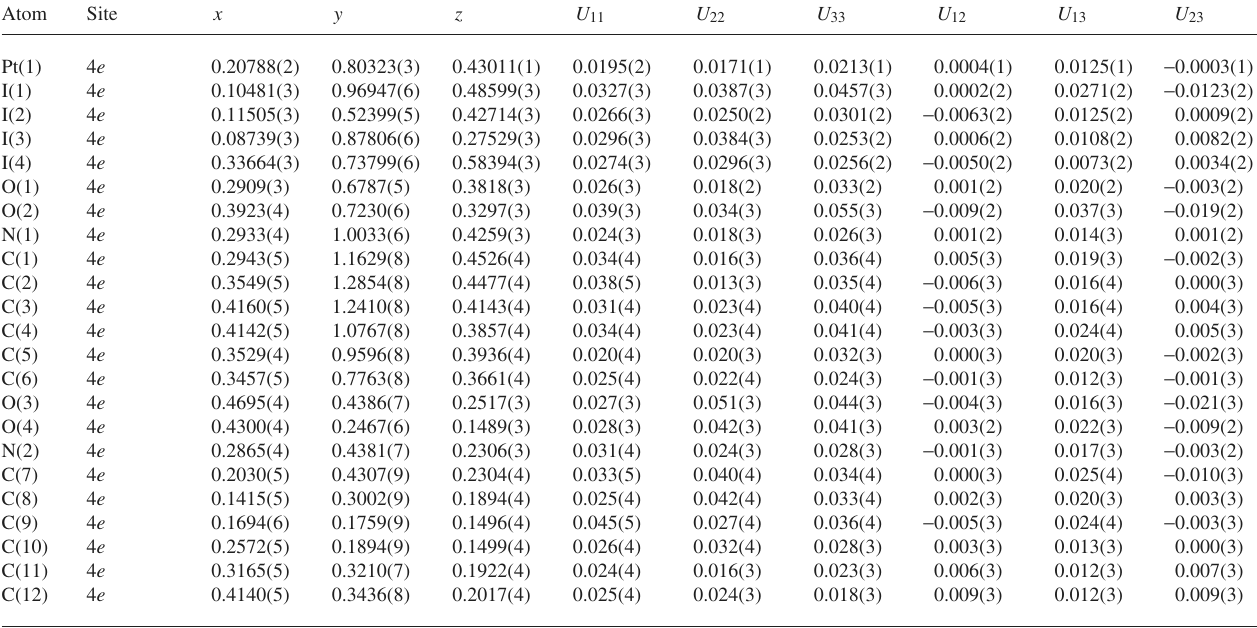
Table 3. Atomic coordinates and displacement parameters (in Å 2 )